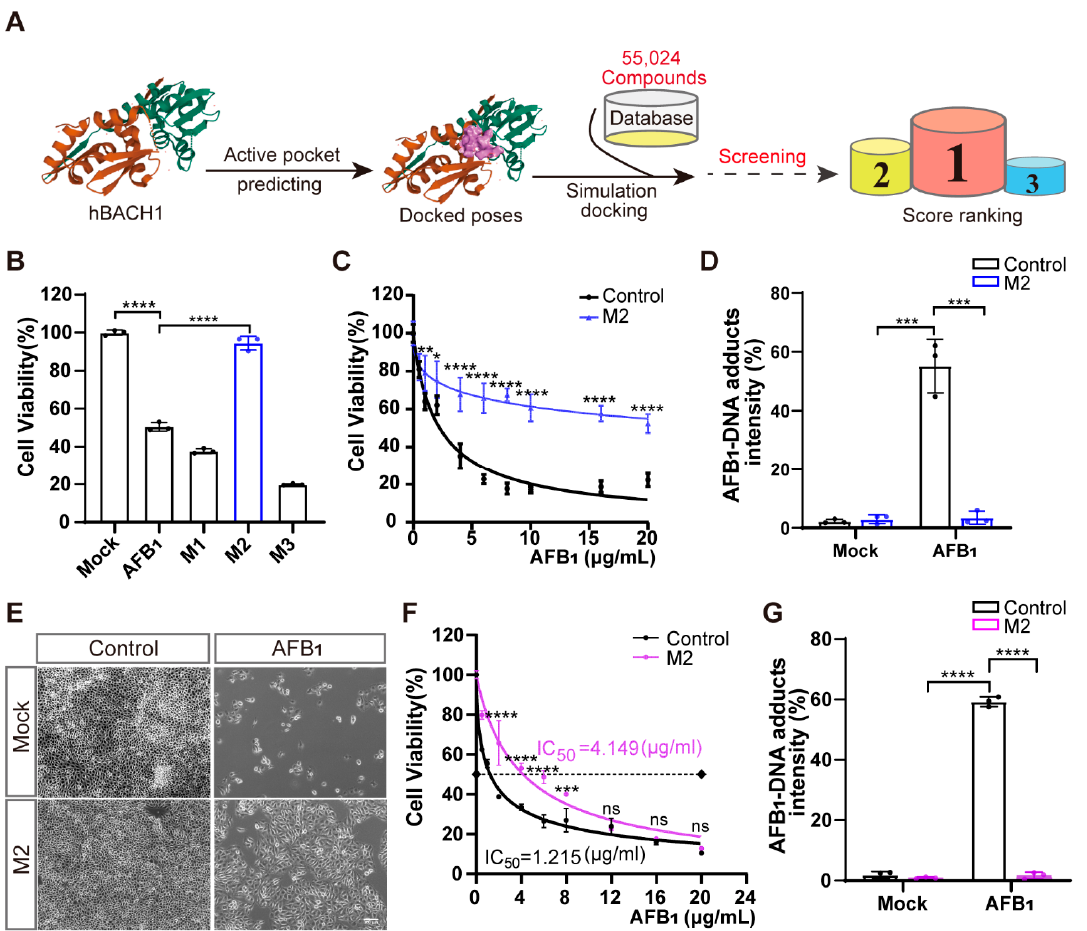
Figure 4. Treatment with inhibitor M2 leads to the highest resistance to aflatoxin B 1 in vitro. ( A ) Workflow of the structure-based virtual screening to identify inhibitors targeting BACH1. ( B ) Validation of the top three inhibitors (M1, M2, and M3) in Huh7 cells by CCK-8 assays. ( C ) Comparation of Huh7 tolerance to different AFB 1 concentrations with and without M2 treatment. ( D ) The relative fluorescence intensity of AFB 1 -DNA adducts in Huh7 cells with and without M2 treatment. ( E ) Representative light microscopy images of AFB 1 -treated PK-15 cells with or without M2 treatment. Scale bar, 100 µ m. ( F ) The IC 50 assays for AFB 1 in PK-15 cells with and without M2 treatment determined with CCK-8 assays. ( G ) The relative fluorescence intensity of AFB 1 -DNA adducts in PK-15 cells with and without M2 treatment. * p < 0.05, ** p < 0.01, *** p < 0.001, **** p < 0.0001, ns, not significant. p values were